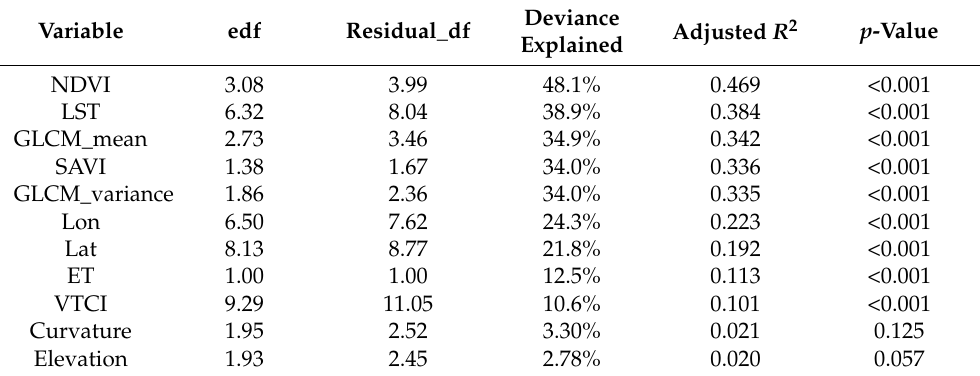
Table 7. Individual effects of variables on AGB in GAM models.